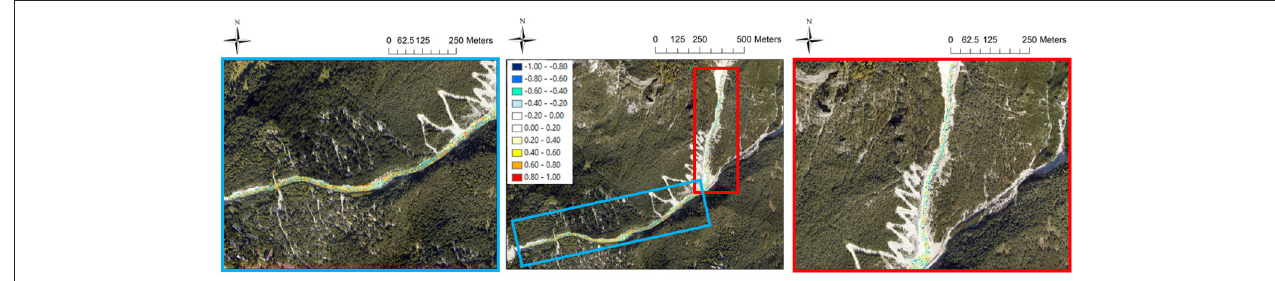
FIGURE 10 | 5 5 moving windows Pearson’s correlation coefficient between the pixel-wise standard deviations of the twelve 50% thinning-derived 1-meter × resolution DEMs heights and the pixel-wise standard deviation of the corresponding twelve 50-years return period simulated erosion/deposition